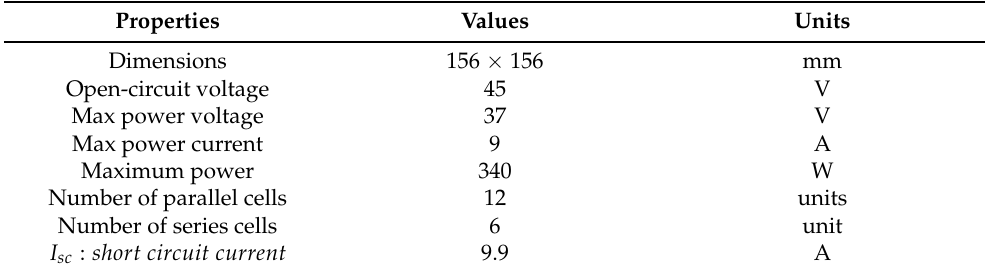
Table 1. Technical data of